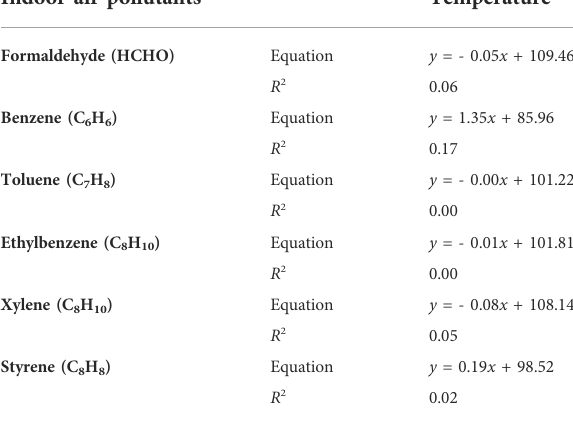
TABLE 7 Linear relationship between each chemical concentration and housing unit